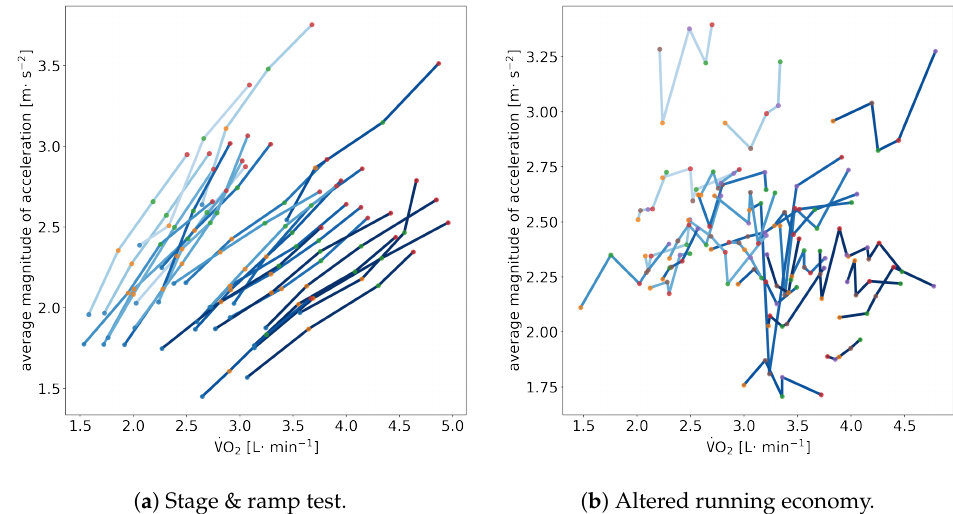
Figure 4. Correlation between ˙VO 2 and the average magnitude of acceleration A during ( a ) the initial stage-ramp test and during ( b ) the running experiment with altered running economy. Each line signifies a single athlete. The shade of blue of the line signifies the body weight of the athlete (darker = heavier). Dots signify the different stages in ( a ) or altered running conditions in ( b